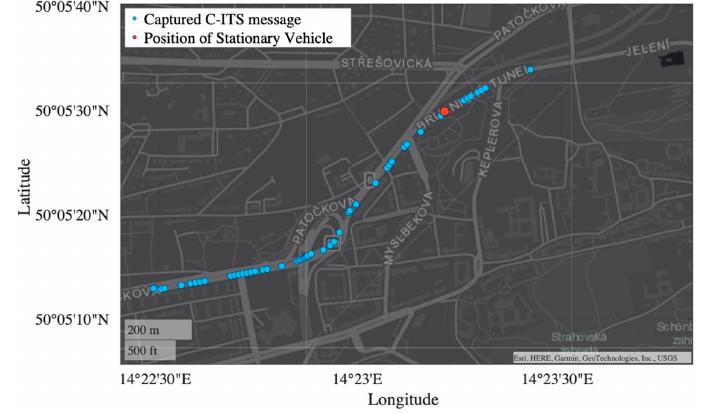
Figure 10. Captured V2X communication over the LTE network.